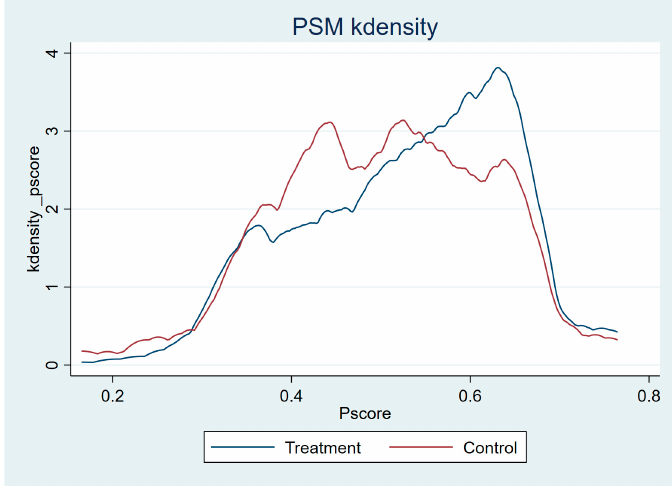
Figure 2. Matched PSM Kdensity map of treatment group and control group.